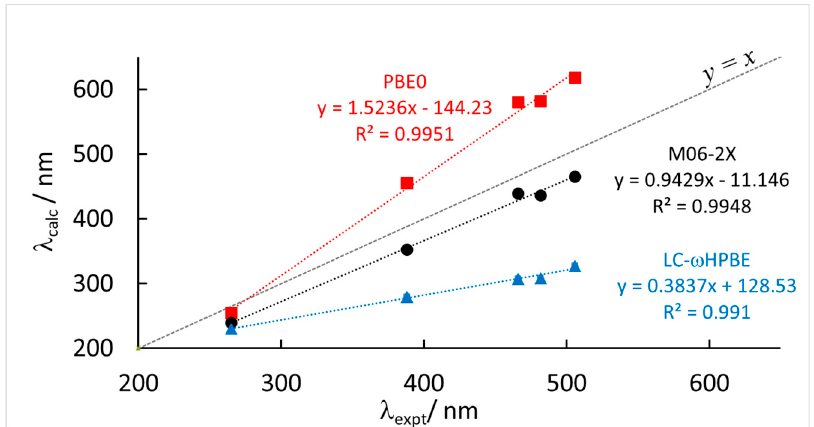
Figure 3. Correlation between calculated ( λ calc ) and experimental ( λ expt ) maximum wavelength absorption of the most red-shifted band of the model systems corresponding to the experimental values of Table 1 and Table 3 at three different levels of theory, TD-DFT(PCM)/6-31+G(d,p). See Table 3 for complete data. Solvent reaction field is included in the TD-DFT calculation (either CH 2 Cl 2 or acetone). Table 3. Experimental (see Table 1) and calculated λ max data (nm) and statistical parameters of the linear fit y = a·x + b . MAE is the mean absolute error; R 2 the correlation coefficient. In the last two columns we report the data of the absorption maxima and statistical parameters in eV. 6-31 + G(d,p) aug-cc-pVTZ 6-31 +